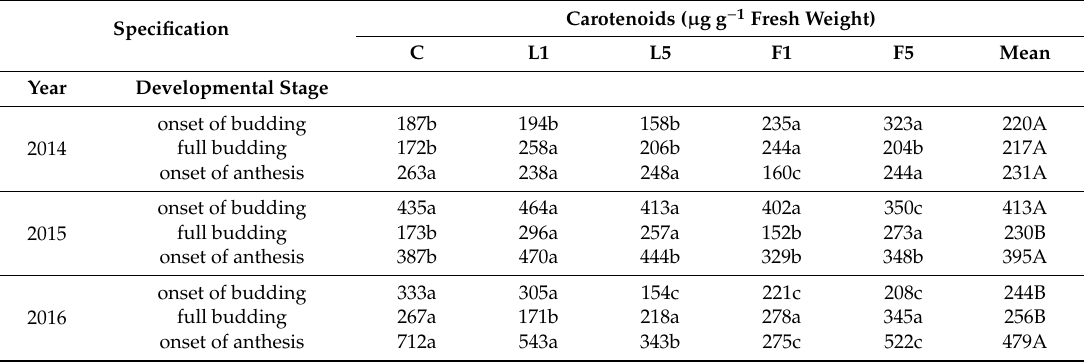
Table 6. Influence of electromagnetic stimulation on carotenoid